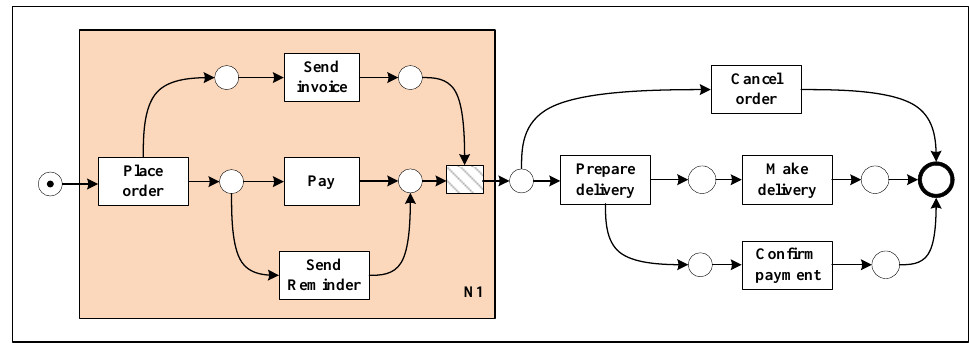
Figure 2. Diagram of Petri net.